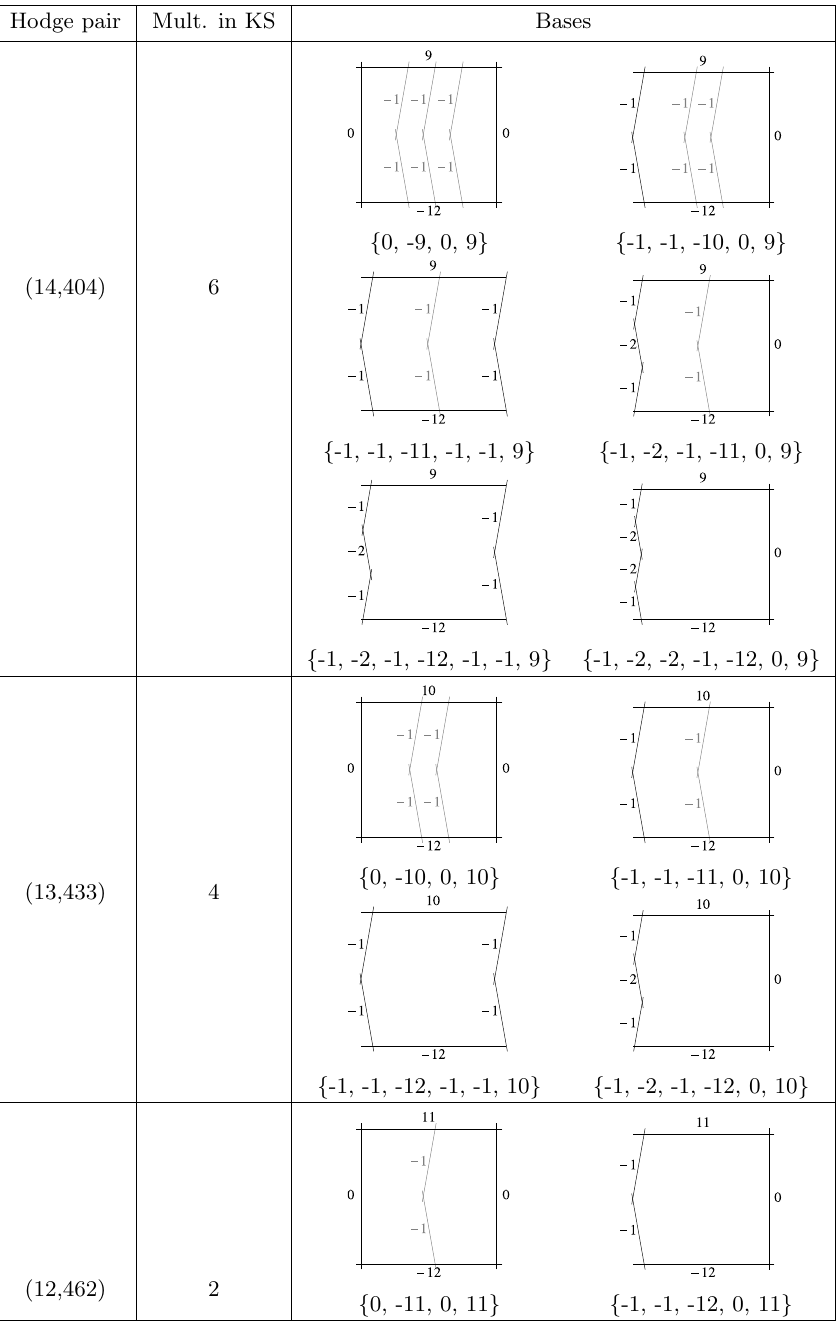
Table 15. A variety of polytope models arise for the Hodge pairs associated with the generic table. The (cid:12)rst graph for each Hodge pair is the generic model, where the (4, 6) singularities on the (cid:0) 9 ; (cid:0) 10, or (cid:0) 11 curve are at non-toric points and the elliptic (cid:12)bration is non-(cid:13)at. In these cases the blow-ups are handled automatically by the resolution of the toric geometry, giving a resolved model corresponding to a (cid:13)at elliptic (cid:12)bration over a \semi-toric" base. There are also toric bases that arise by blowing up one or more of the (4, 6) points at toric points, giving polytopes with toric (cid:12)brations over blow-ups of the Hirzebruch surfaces. When multiple (4, 6) points coincide this corresponds to a limit with a (cid:0) 2 curve in the base. For each polytope the base of the (cid:12)bration is a toric surface given by the curves on the outside of the diagram, with self-intersections as labeled.